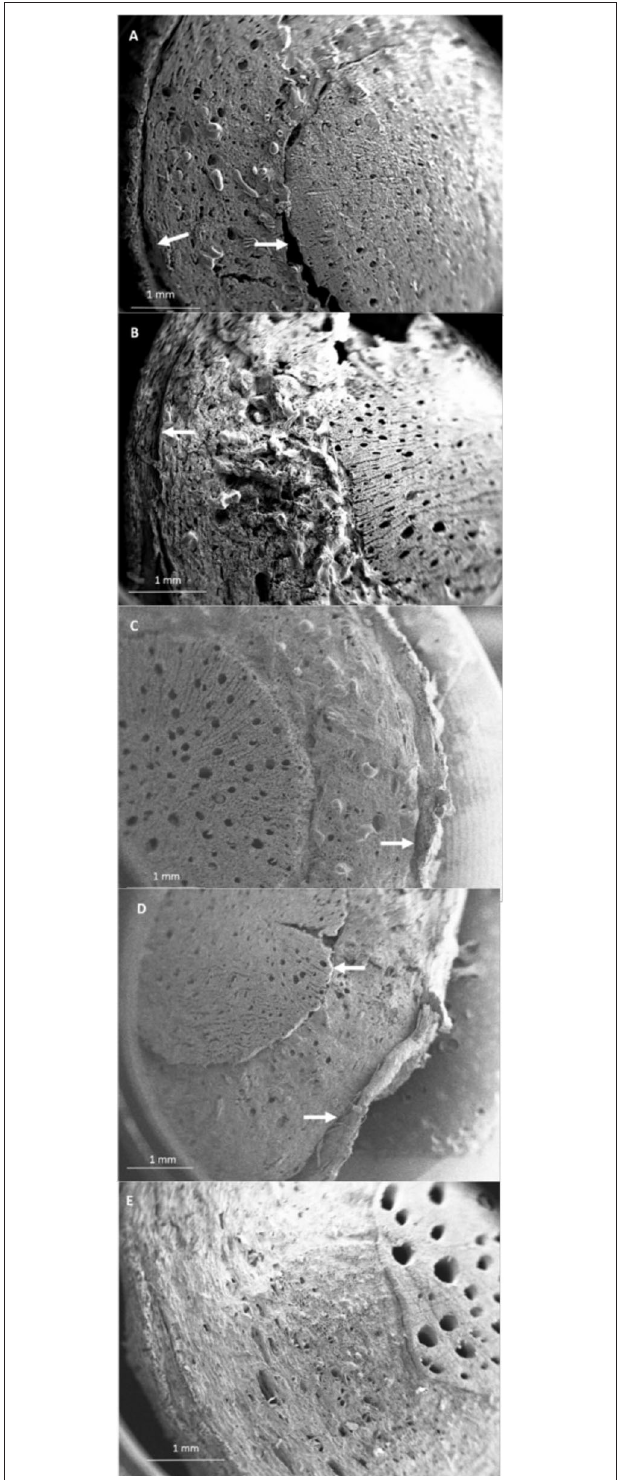
FIGURE 4 | SEM micrographs showing modifications of the root anatomy in kiwifruit plants grown under different soil management conditions. Arrows are showing detachment in correspondence of the meristematic layers between xylem-phloem and phloem-cortex. (A) Control (C), (B) Ridged + Compost (RC), (C) Ridged + Inoculum (RI), (D) Ridged (R), (E) root of a healthy plant from a private